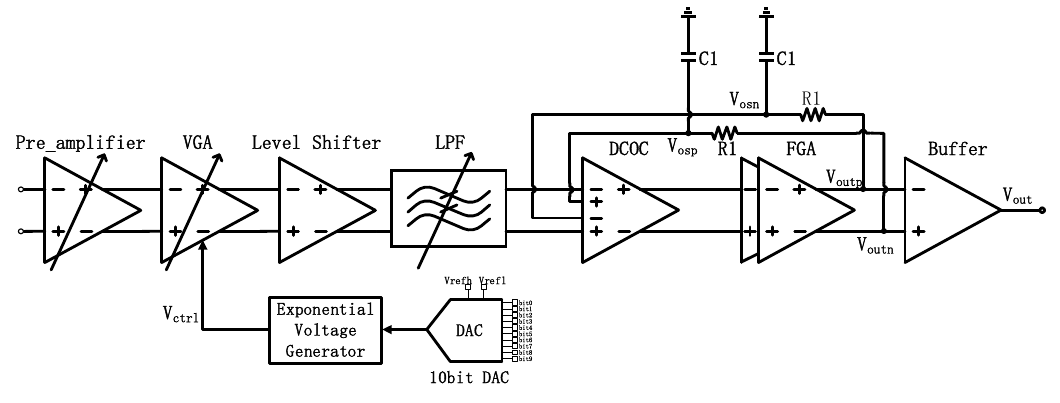
Figure 3. Analog baseband architecture.